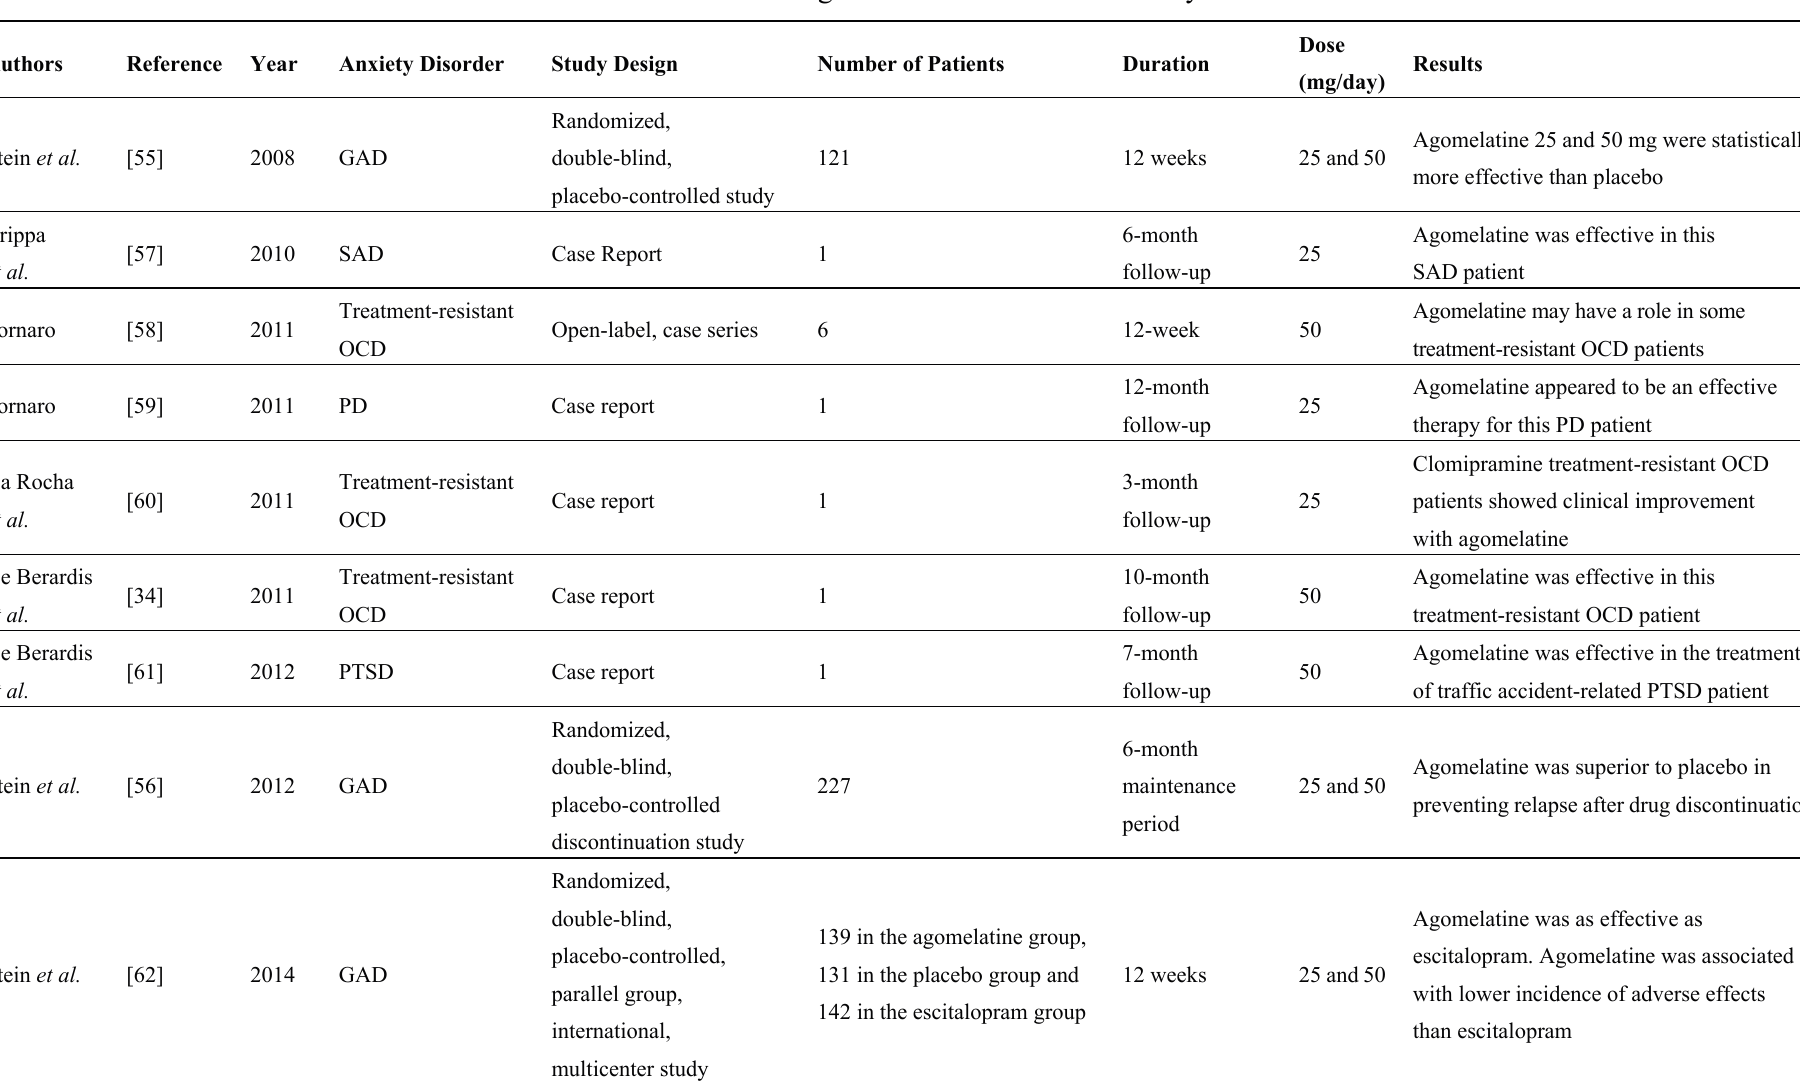
Table 1. Published data on agomelatine treatment of anxiety